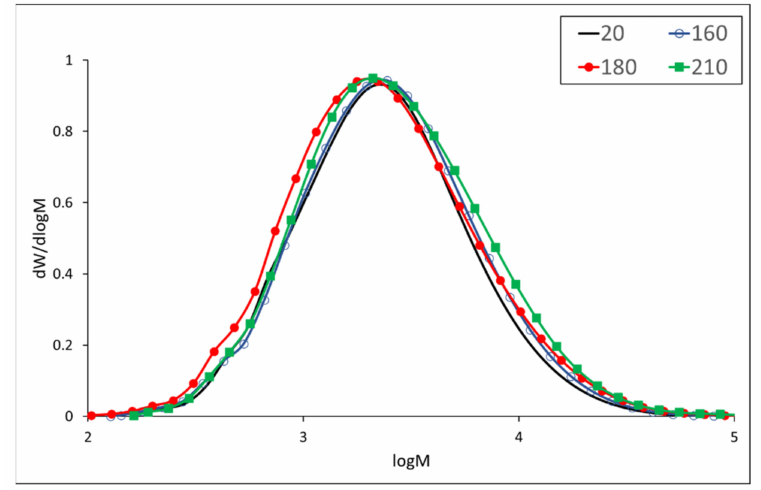
Figure 2. Molecular weight distribution of padauk wood lignin.